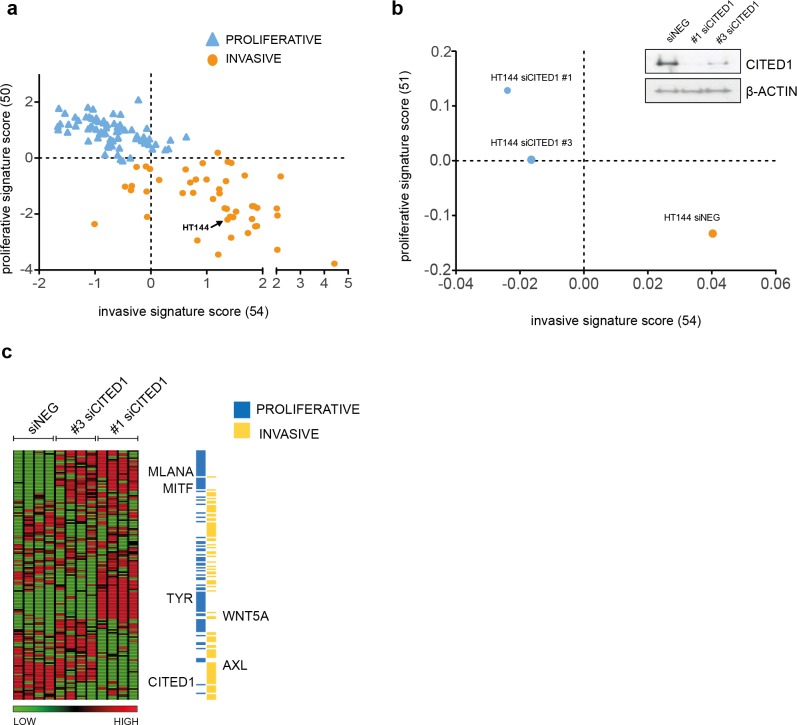
CITED1 silencing induces a phenotype switch.(A) 120 melanoma cell lines are shown distributed on the basis of the phenotype score. The HT144 cells chosen to study the effects of CITED1 downregulation are indicated. (B) Following CITED1 downregulation a phenotype shift is observed indicated by their scatter position change according to the average expression score of genes that distinguish invasive from proliferative phenotype. For the 120 melanoma cell lines (Affymetrix platform) the expression score was derived from expression levels of 50 and 54 proliferative and invasive genes with matching genes symbols, respectively, while for the HT144 experiment (Illumina platform), 51 and 54 proliferative and invasive genes with matching genes symbols were retrieved. A Western blot of the degree of protein downregulation of CITED1 at the time of the expression analysis is also shown. β-Actin is used as a loading control (inset). (C) A heatmap comprising the ‘invasive’ and ‘proliferative’ signature genes illustrating how they are altered by CITED1 silencing; #1 and #3 denote two separate siRNAs targeting CITED1 and the vertical lanes represent the 4 replicates per treatment.